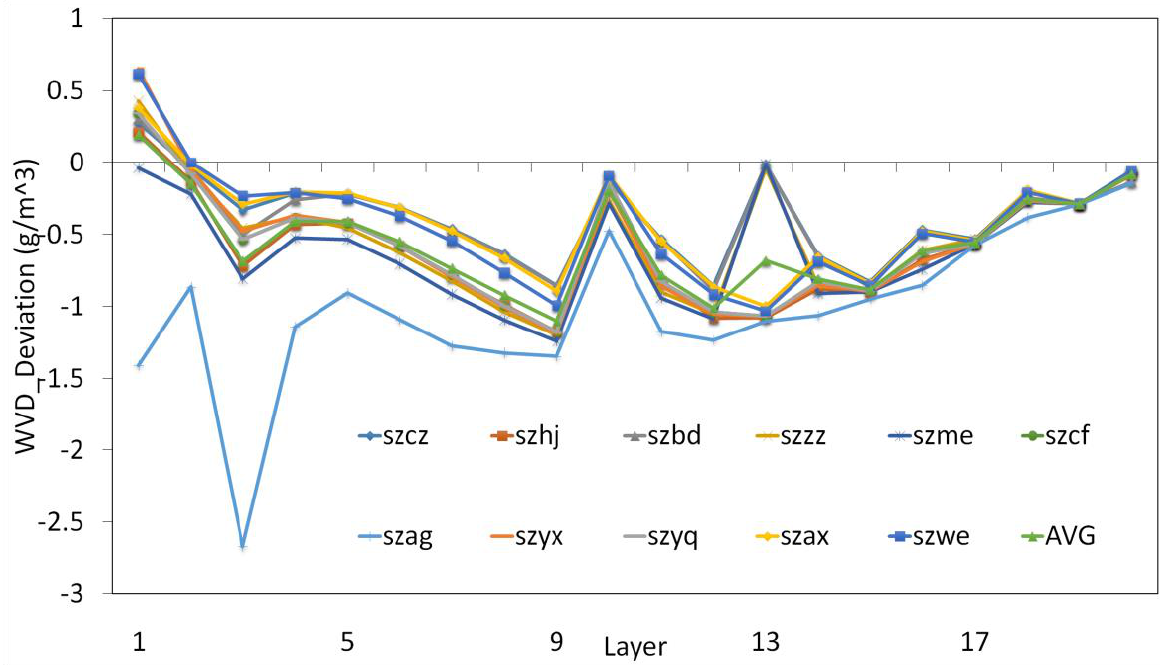
Figure 9. The deviation between the water vapor density of the tomography and GFS data.